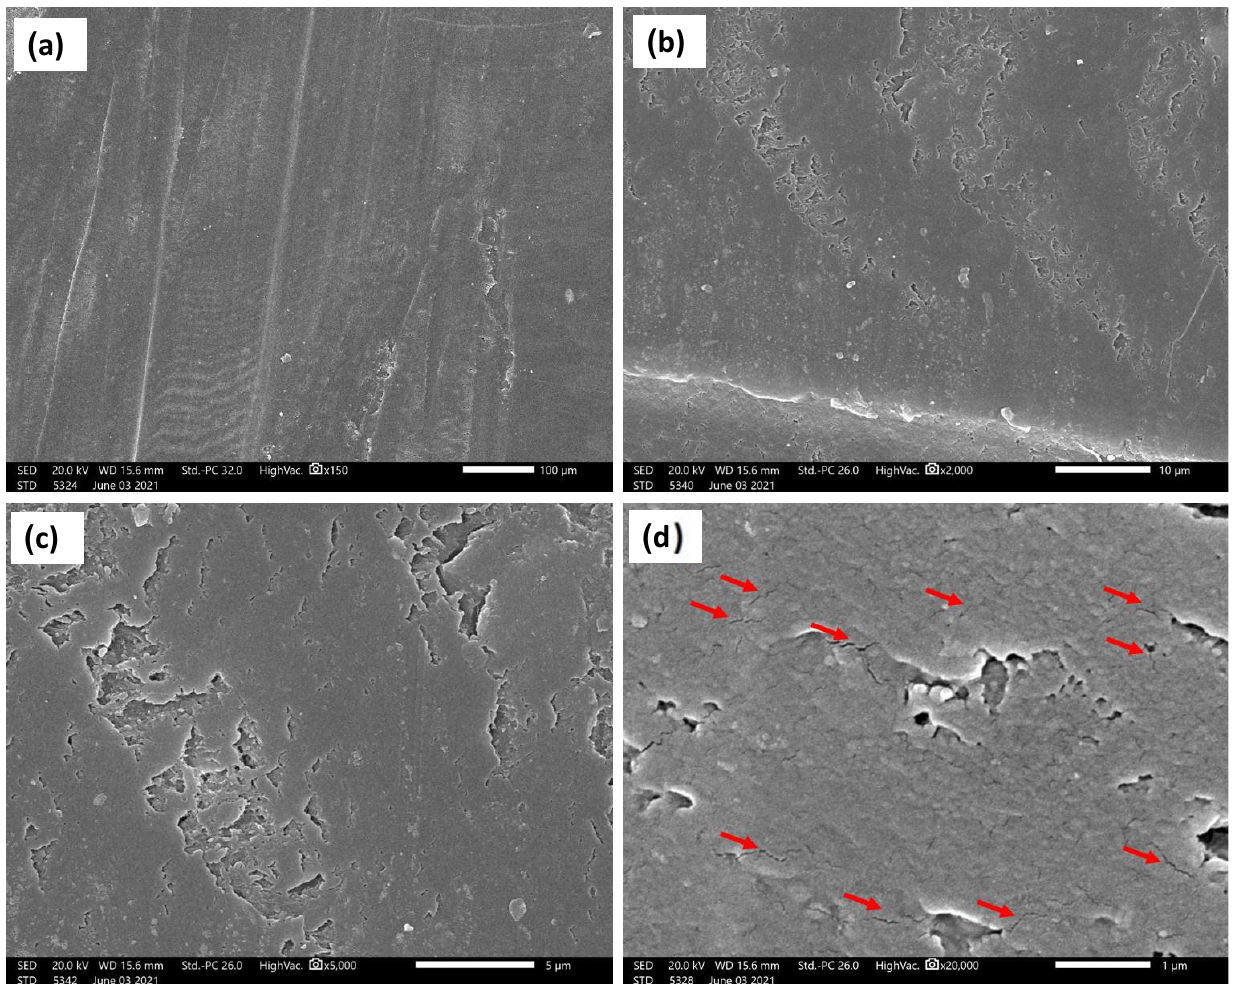
Figure 12. SEM micrographs at different magnifications and positions of the base acrylic material after wear test. Red arrows indicate the microcracks. ( a ) 150×, ( b )2000×, ( c ) 5000× and ( d ) 20,000×.